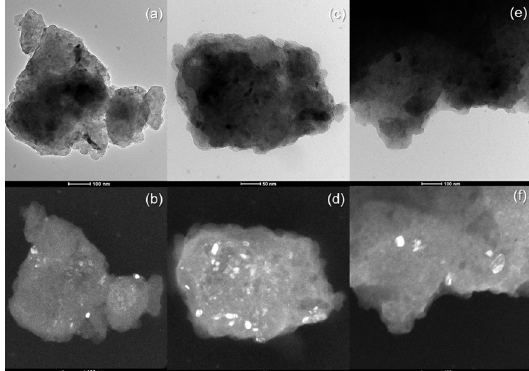
Figure 6. Bright field (top) and Centered Dark-Field (bottom) obtained for regions of (101) TiO -anatase diffraction ring for the samples 2 MgH +NR550(a,b), MgH +NR650(c,d) and MgH 2 2 highlighting TiO nanoparticles distributed within the hydride matrix. 2